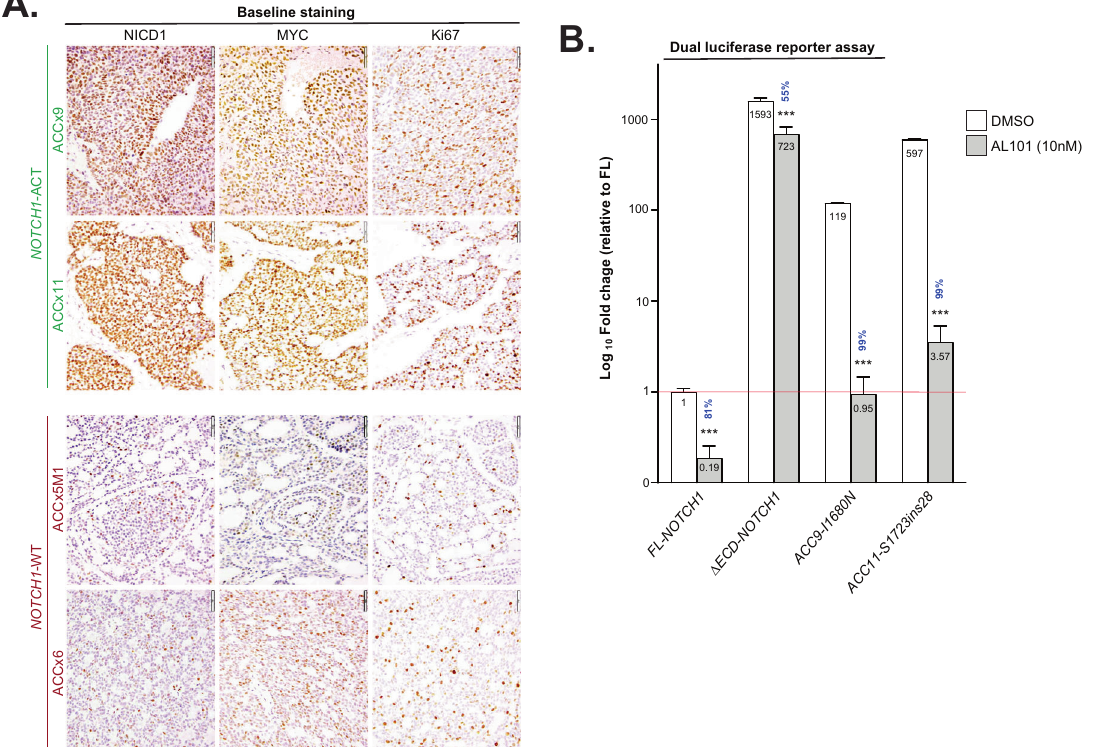
Fig. 2 NOTCH1 mutations in ACCx9 and ACCx11 PDX tumors show high levels of NOTCH1 signaling that is inhibited by AL101. A Tumor sections from four PDX models (ACCx9, ACCx11, ACCx5M1, and ACC6) collected at baseline (before implantation) were stained for NICD1, MYC, and Ki67 using an IHC. Representative images are shown. B Transactivation activity of wild-type full-length NOTCH1 ( FL-NOTCH1 ), constitutively active γ -secretase dependent form of the NOTCH1 receptor ( Δ ECD-NOTCH1 ), and alleles containing mutations carried by ACCx9 and ACCx11 PDX tumors ( ACC9-I1680N and ACC11-S1723ins28 , respectively) was assessed using a dual-luciferase reporter assay. Bars represent the average of fi ve independent experiments performed in triplicates and indicate fold-change relative to FL-NOTCH1 (red line). Percent inhibition induced by AL101 (gray bars) relative to DMSO (white bars) is indicated in blue. *** p <